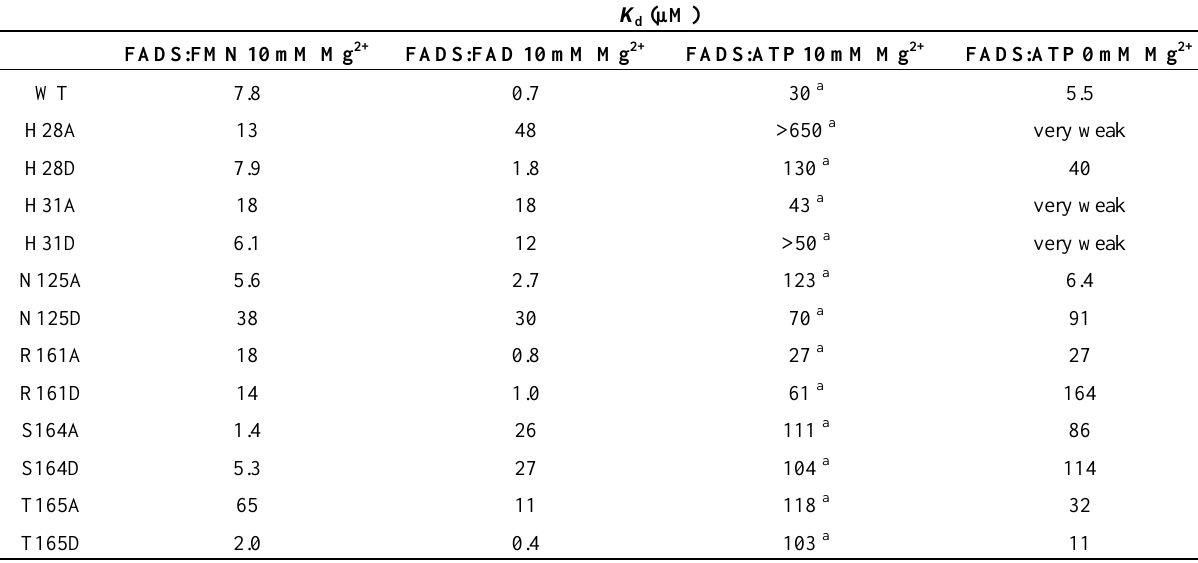
Table 3. Dissociation constants for the interaction of WT and mutated forms of Ca FADS with FMN, FAD and ATP as determined by ITC. Data obtained at 25 °C in 20 mM PIPES pH 7.0, at the indicated MgCl concentration. Errors in K are considered within ±15%, the 2 d value taken being larger than the standard deviation between at least three independent experiments and the numerical error after fitting analysis to the equation describing a model for either one or two independent binding